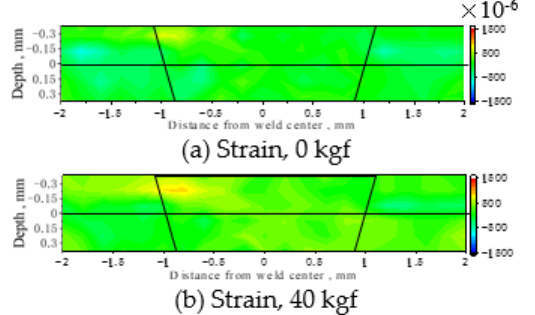
Figure 11. Two-dimensional distribution of lattice strain in the other specimen at 530 °C under a tensile load.